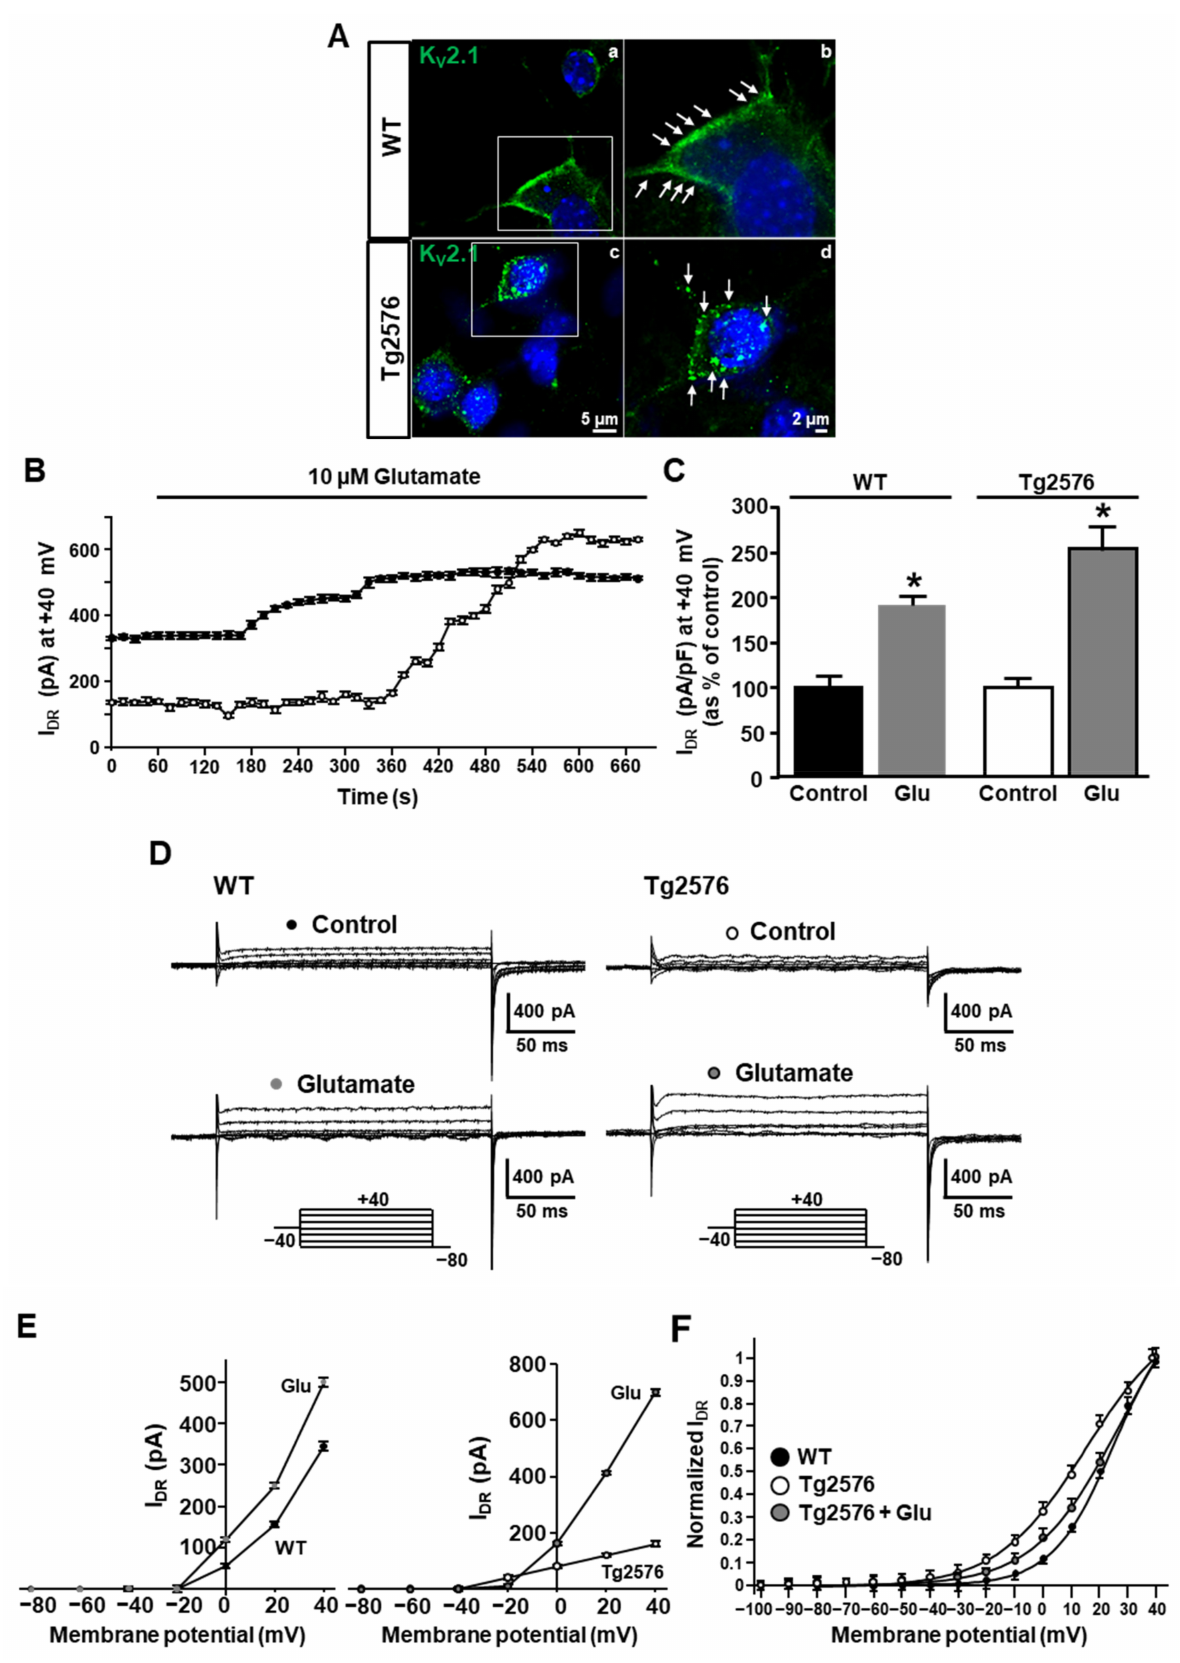
Figure 4. K V 2.1 clustering and effect of glutamate on I DR in WT and Tg2576 primary